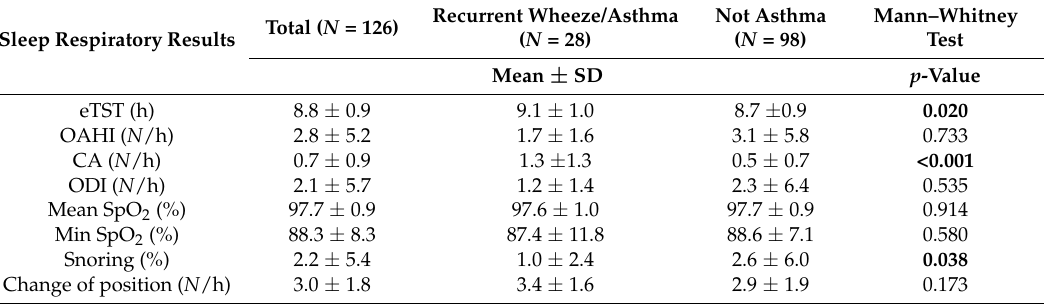
Table 2. Summary of the in-laboratory overnight polygraphic studies.